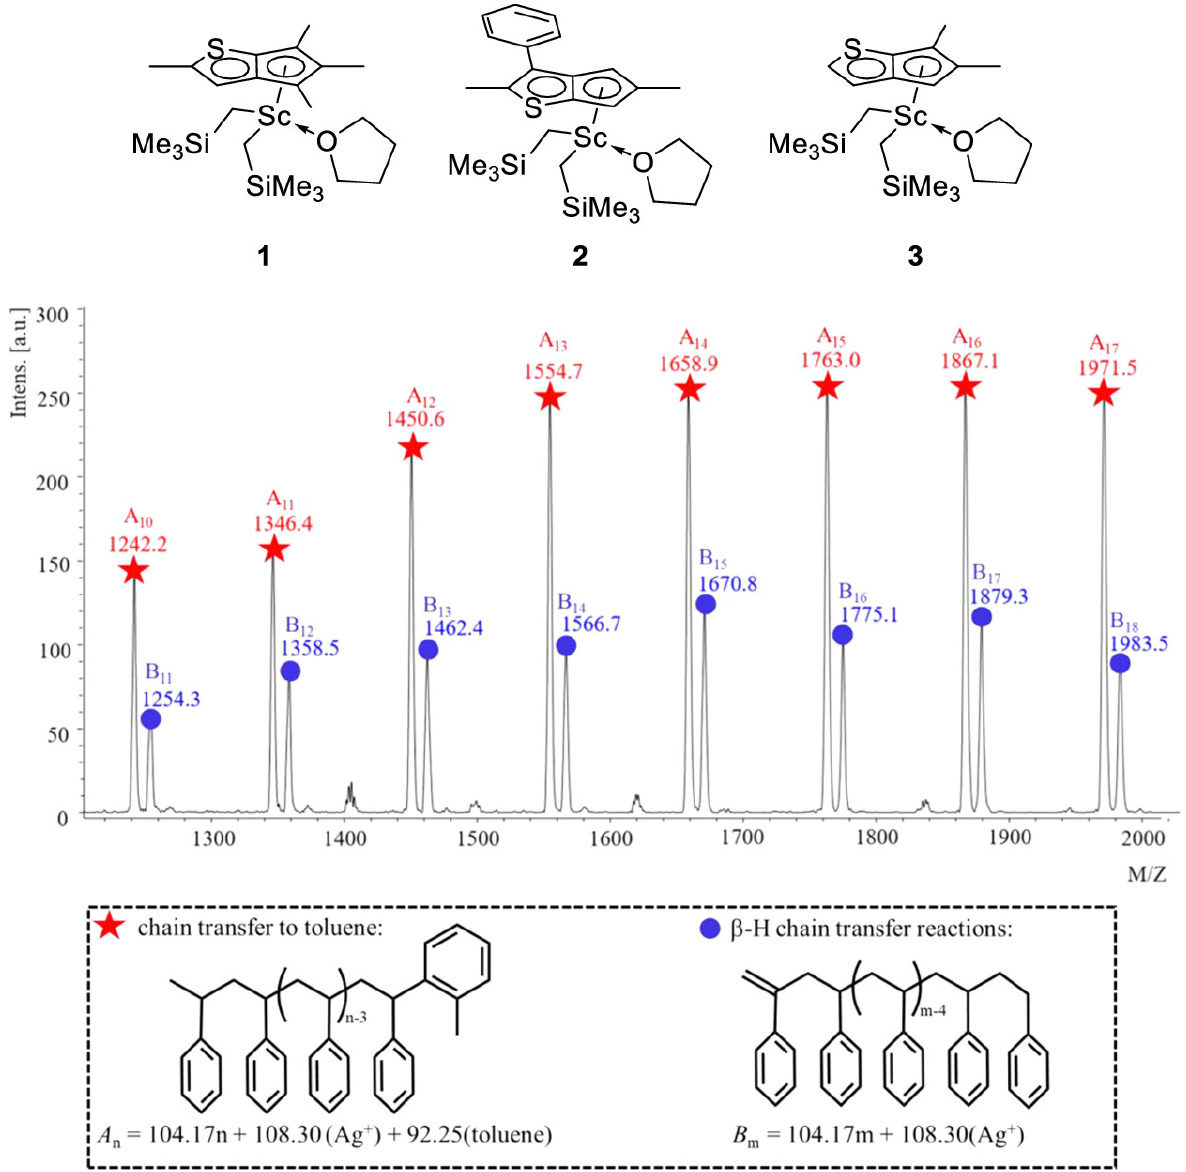
Figure 6. Sc precatalysts ( top ) and MALDI-TOF spectrum of the polystyrene samples ( bottom ) reported by Cui and coworkers. Adapted with permission from Reference [39]. Copyright 2020 American Chemical Society.